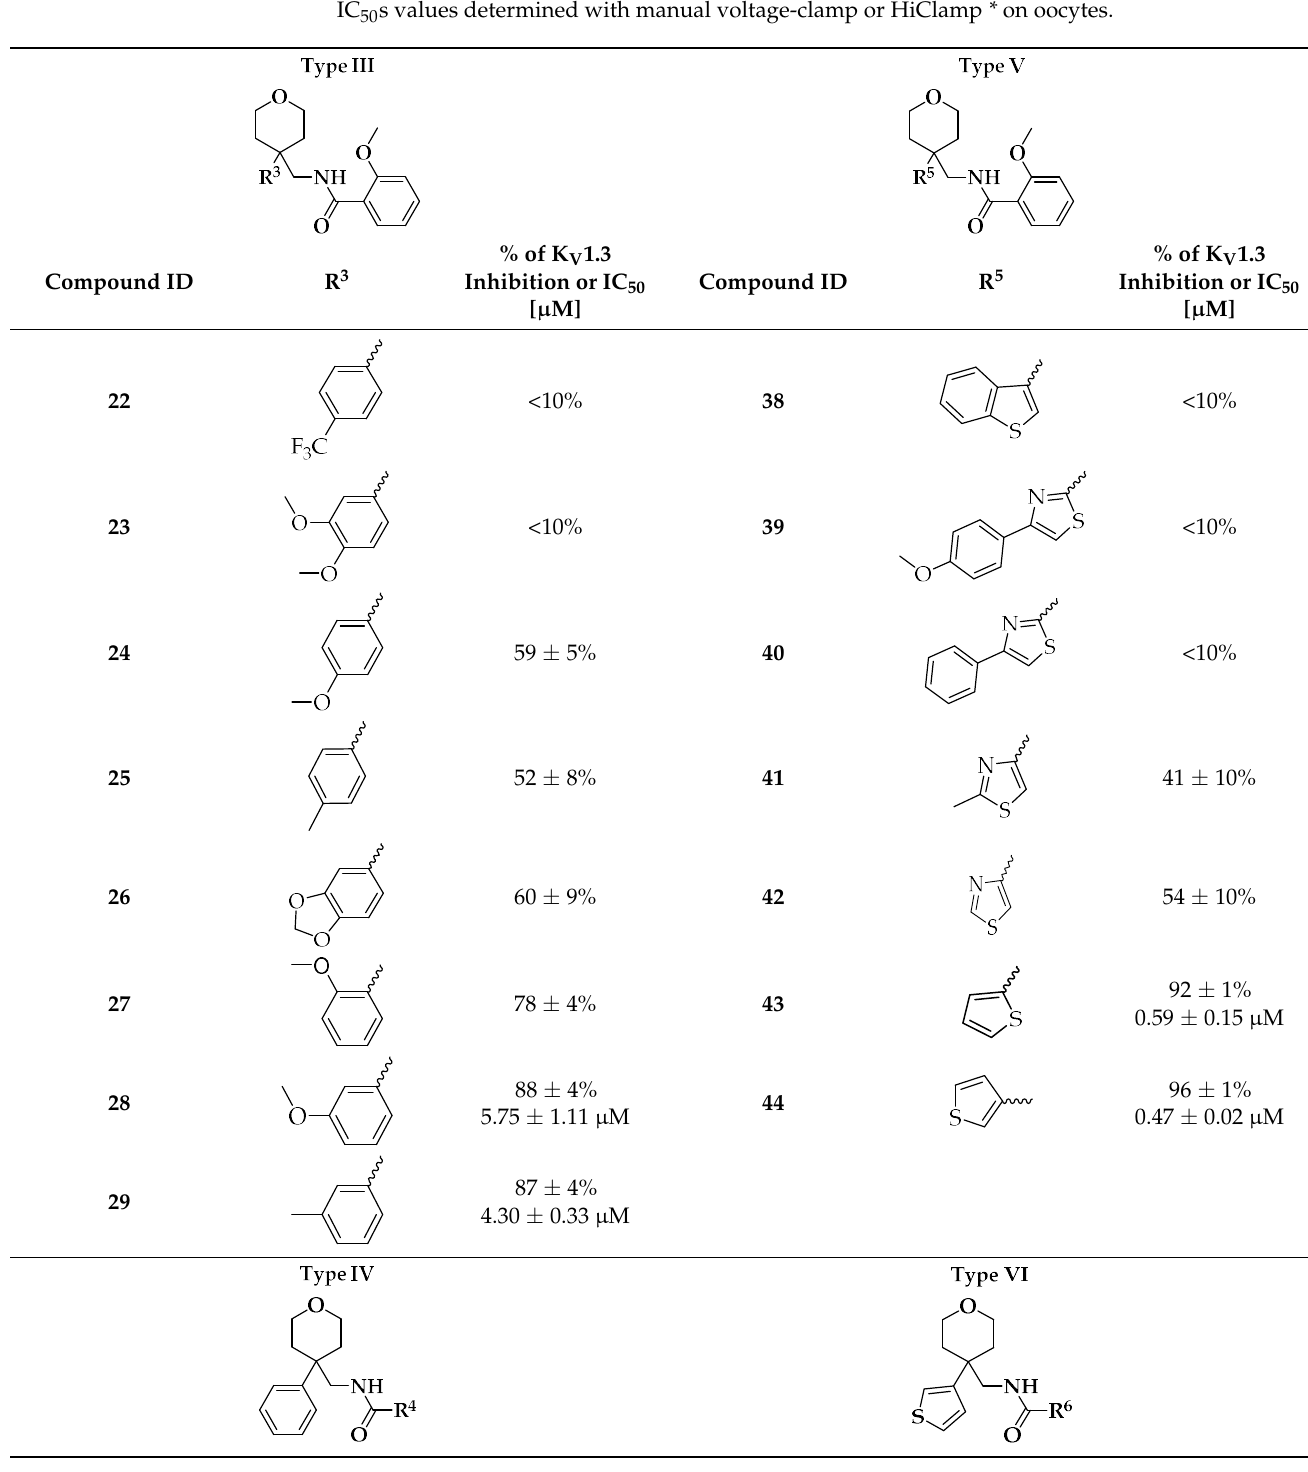
Table 2. Structures and K V 1.3 inhibitory potencies of the designed and synthesized Type IV–VI analogs 22 – 51 , manually voltage-clamped to determine the percentage of inhibition at 10 µM and the IC 50 s values determined with manual voltage-clamp or HiClamp * on oocytes.